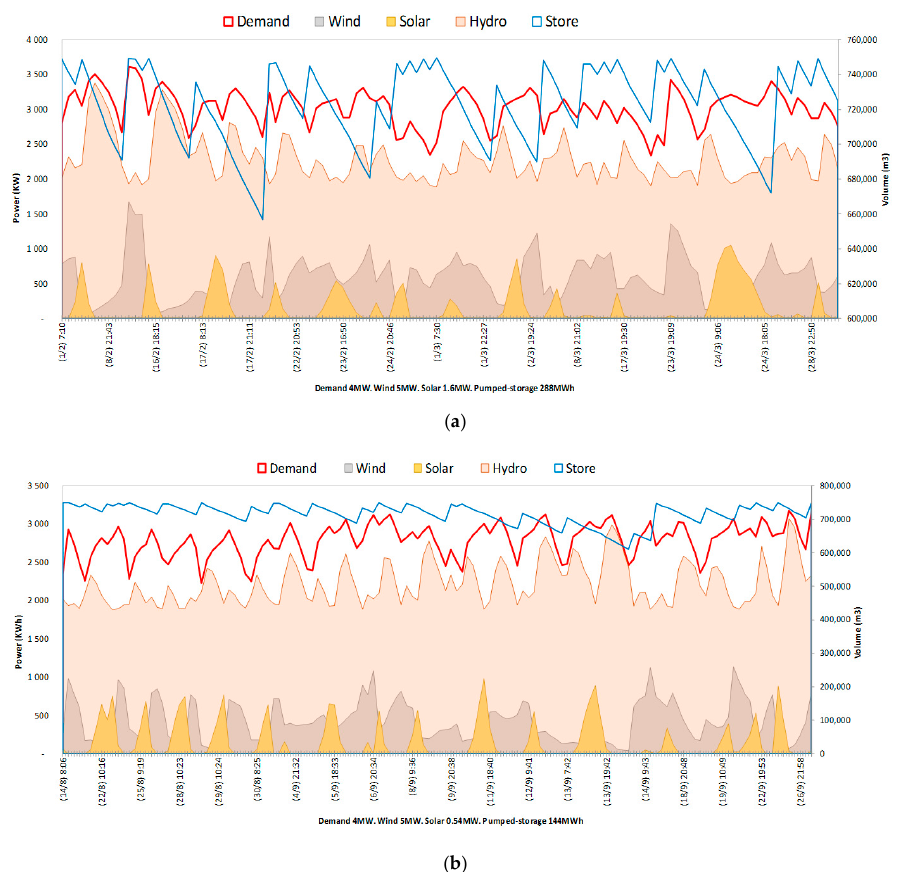
Figure 13. Total amount of energy stored vs demand in scenario 4, between February and March ( a ) and August and September ( b ).